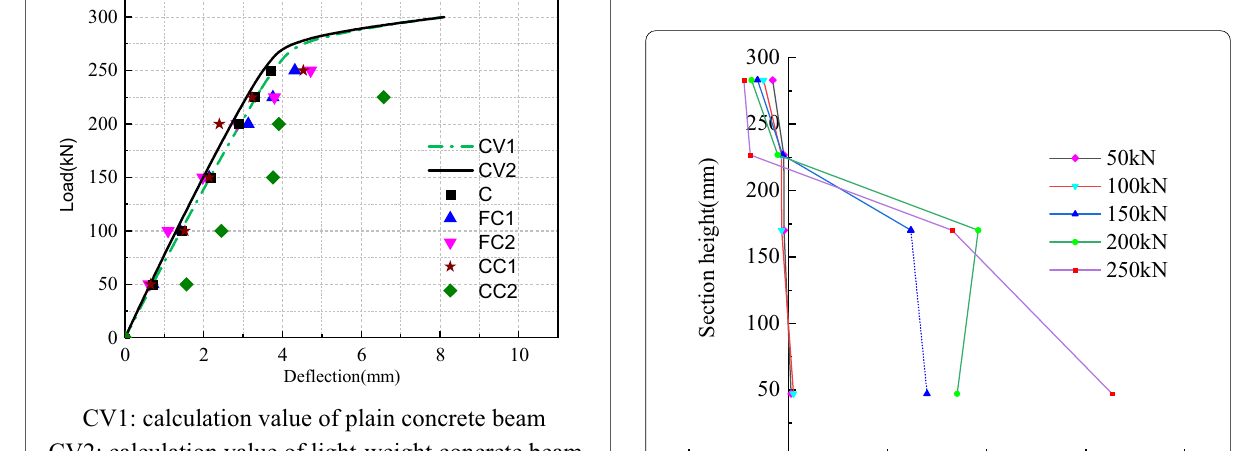
Fig.6 Load deflection of concrete beams. CV1 calculation value of plain concrete beam, CV2 calculation value of lightweight concrete beam. Fig. 7 Distribution of ceramic concrete strain along section